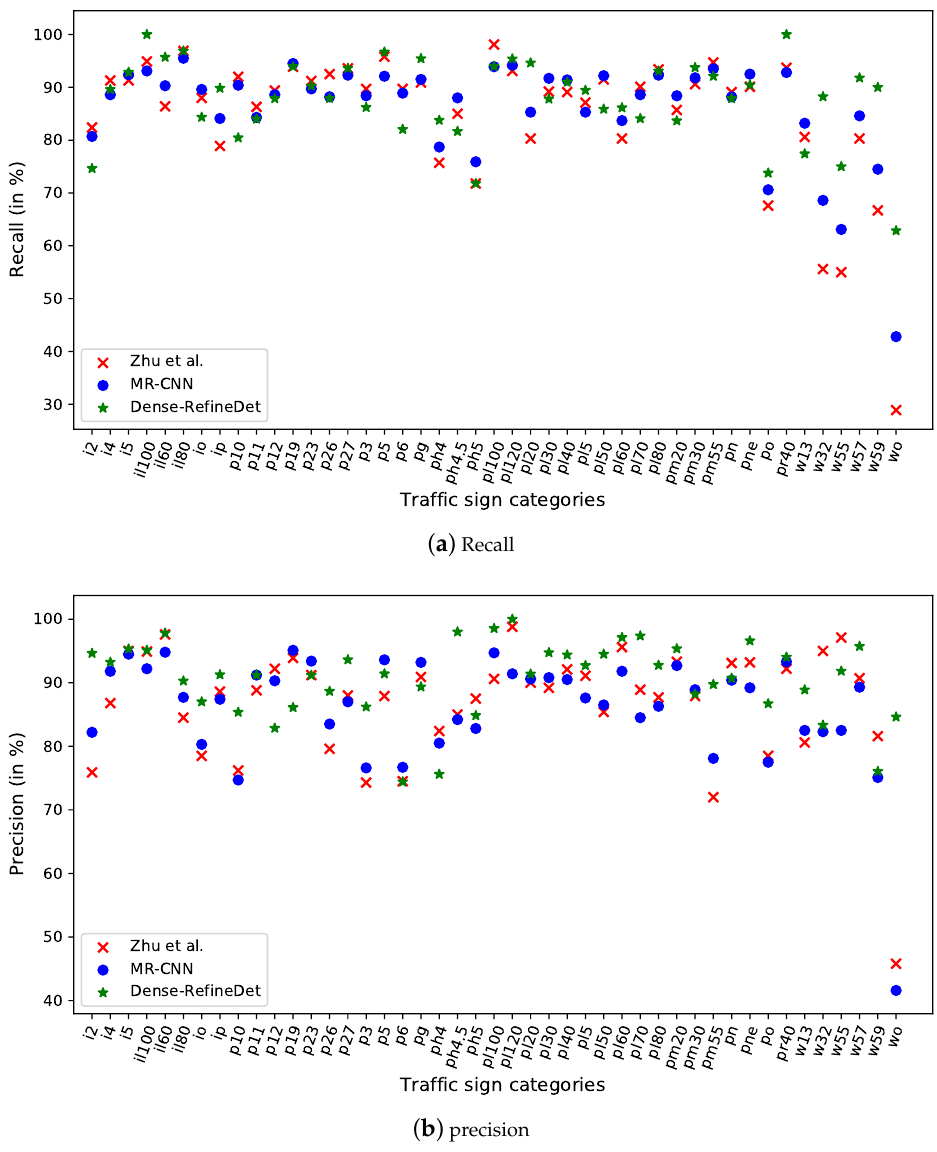
Figure 5. Comparisons of detection results on 45 categories. ( a ) Recall, ( b )